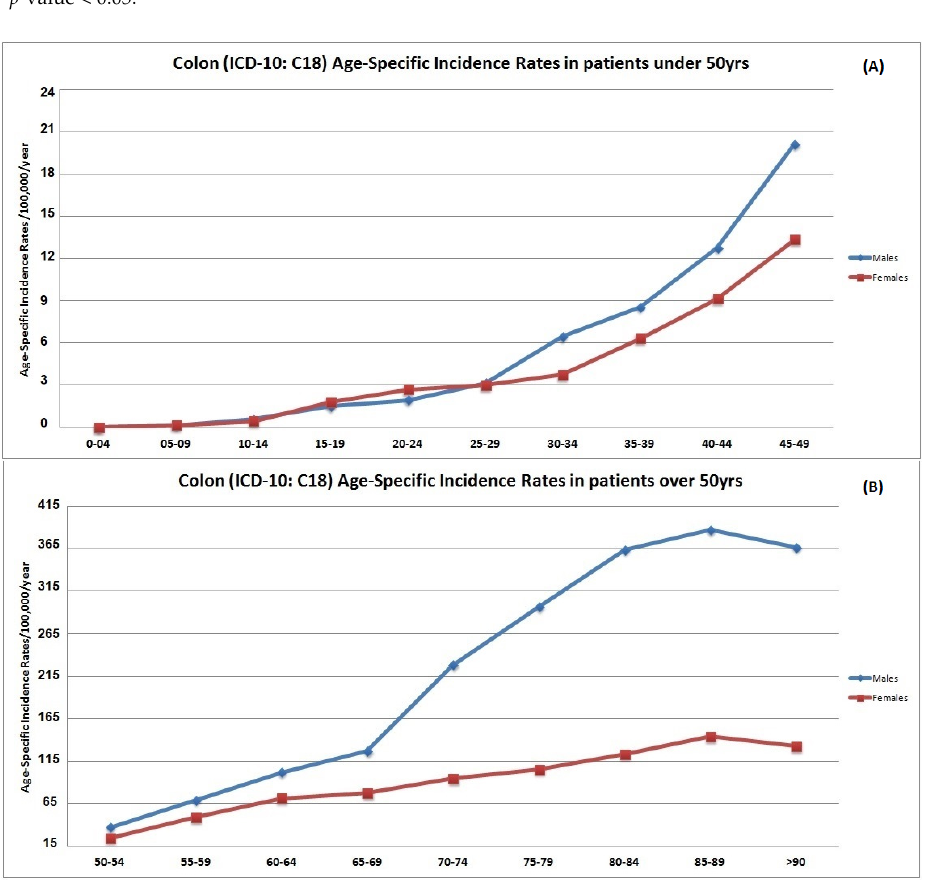
Figure 1. Age-specific incidence rates (ASpIR) per 100,000 population per year in colon cancer patients under ( A ) and over ( B ) 50 years. Observed and projected annual change (%) of colon ASpIR per age group are presented in Figure 2. Statistically significant changes (%) were observed in most age groups ( p < 0.05). In particular, ASpIR presented a 29.6% increase from 2001 to 2011 in the age group of 20–34 years and further increase is expected from 2022–2030 (projected change, 42.8%). Similar trends were observed in the age group of 35–49 years from 2001 to 2011. In contrast, the ages over 50 years presented declines in the ASpIR starting from − 12.4% (2001–2011) to − 25.8% (2012–2021) for individuals aged 50–74 years, and from − 31.3% (2001–2011) to − 39.6% (2012–2021) for those aged > 75 years. Figure 2. Observed and projected annual change (%) of colon cancer incidence rates per age group.